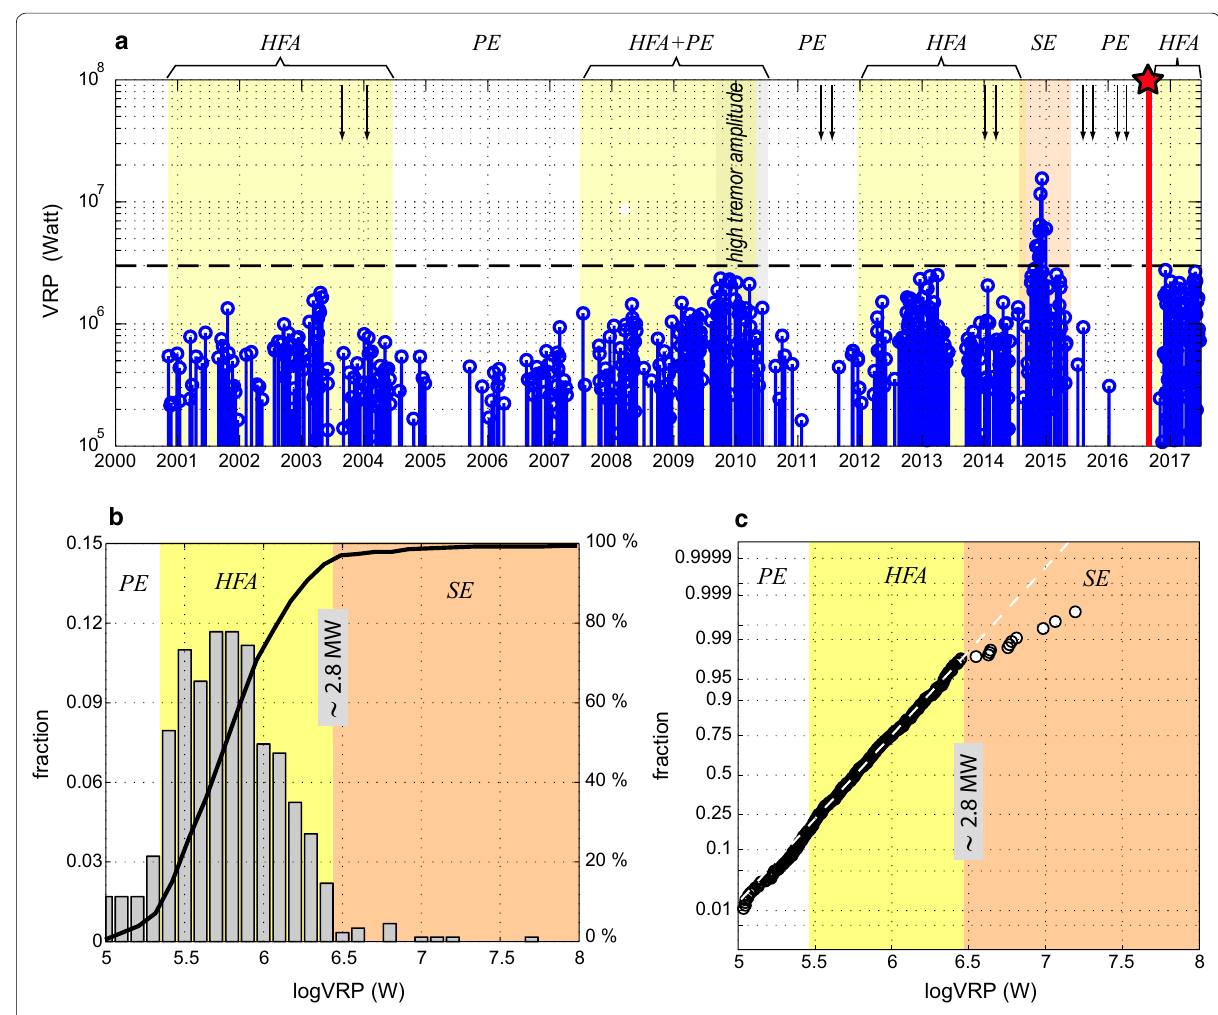
Fig. 6 a Time series of volcanic radiative power (VRP) recorded at Aso volcano between 2000 and 2017. Colored field indicate the principal phases of activity (PE: Phreatic and/or phreatomagmatic events; HFA: high fumarolic activity; SE: Strombolian eruptions). The red star indicates the timing of a major phreatomagmatic explosion occurred on October 8, 2016, after the longest period of thermal rest. b Statistical distribution of VRP data (log-transformed). c Probabilistic plot of VRP data (log-transformed) showing two clear populations separated at 2.8 MW. The arrows represent